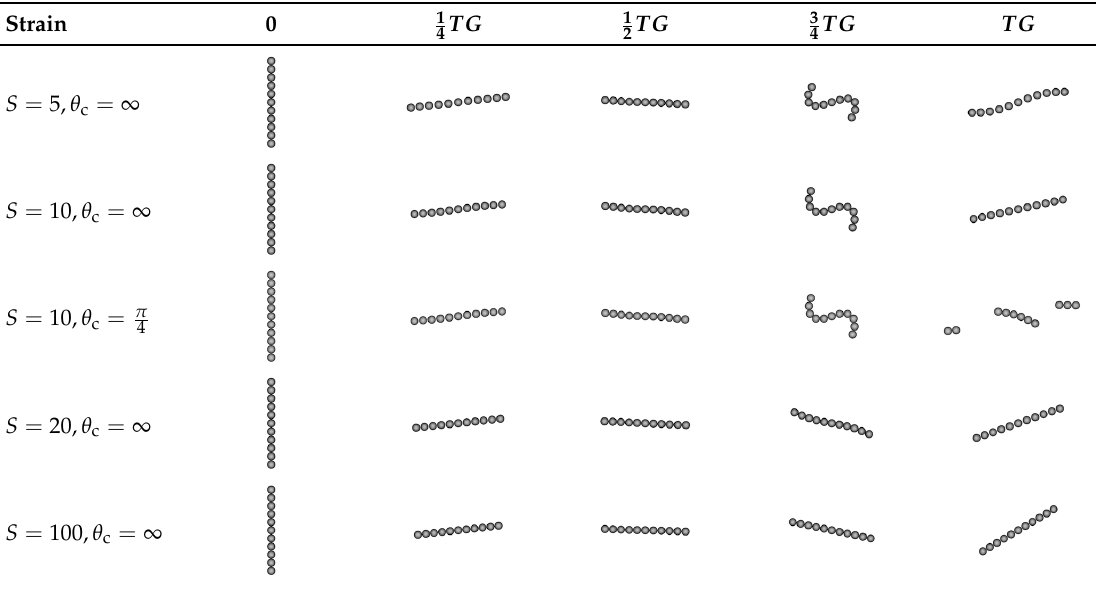
is shown to demonstrate fiber 4